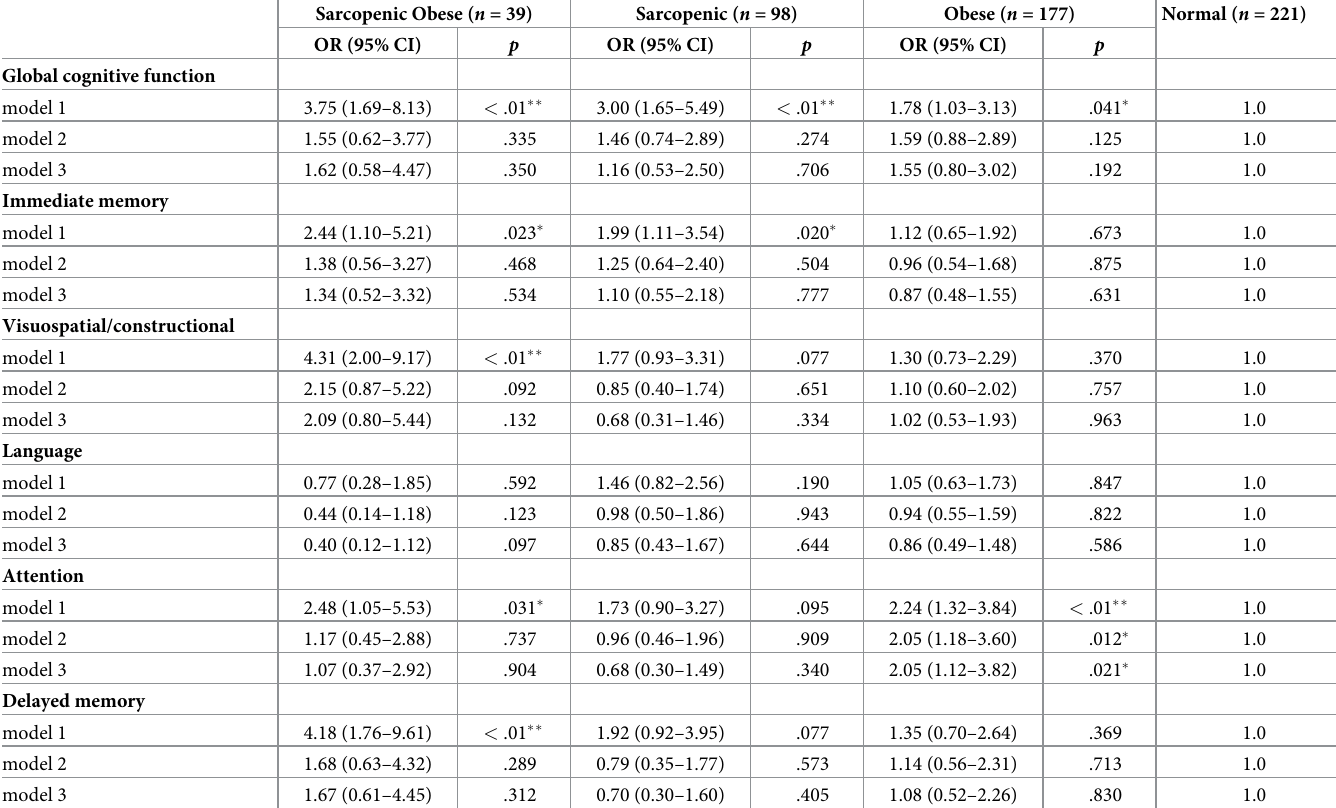
Table 2. Association between sarcopenic obesity and risk of impairment in different domains of cognitive function.